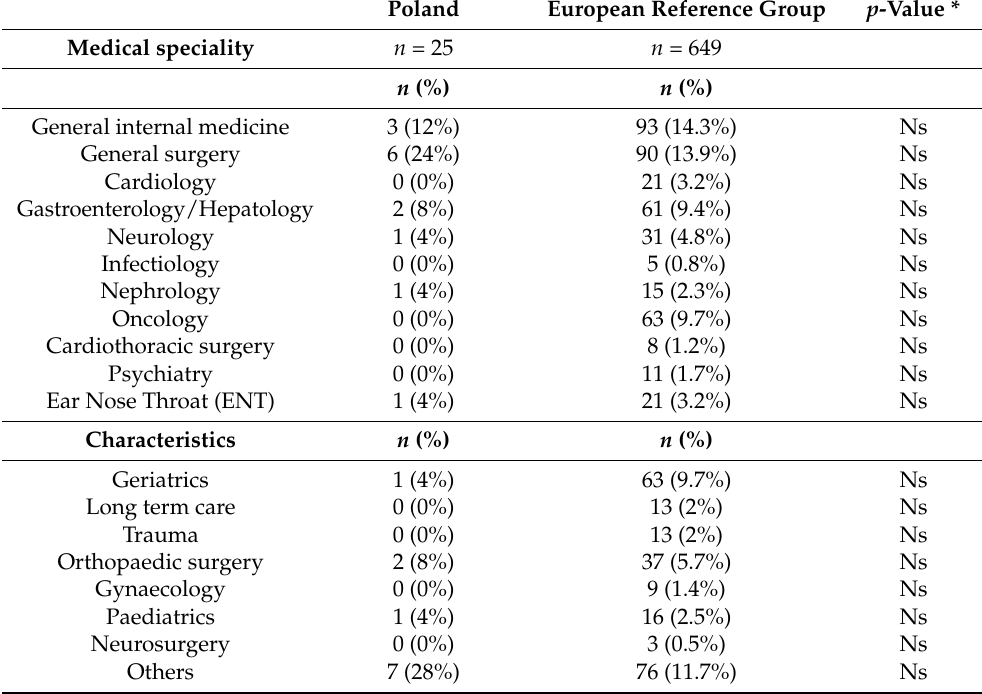
Table 3. Medical specialties included in the